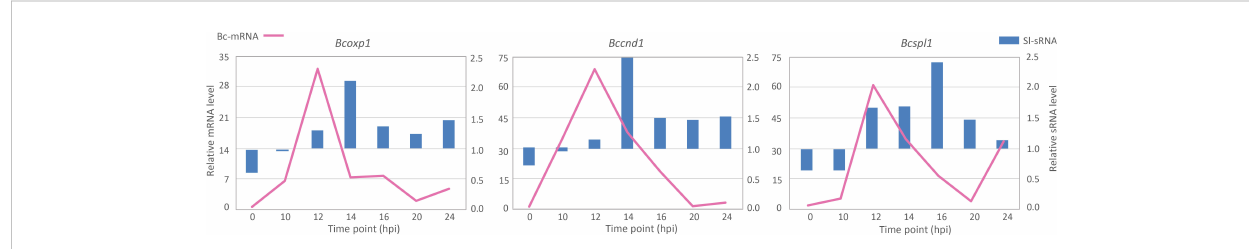
FIGURE 1 Quanti fi cation of production levels of three Sl-sRNAs (blue bars) and mRNA levels of their predicted target genes in B . cinerea (pink lines). The expression data were collected from four experiments, and the predicted target B . cinerea gene is indicated above each